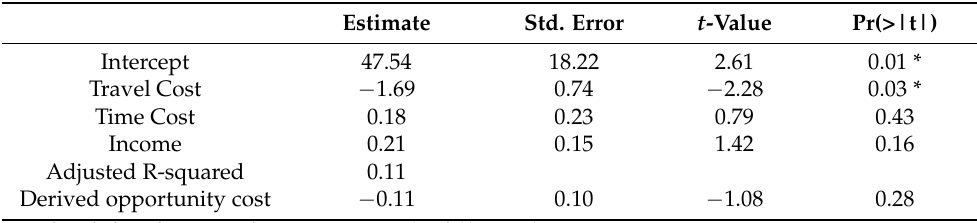
Table 1. Model testing the opportunity cost of time.